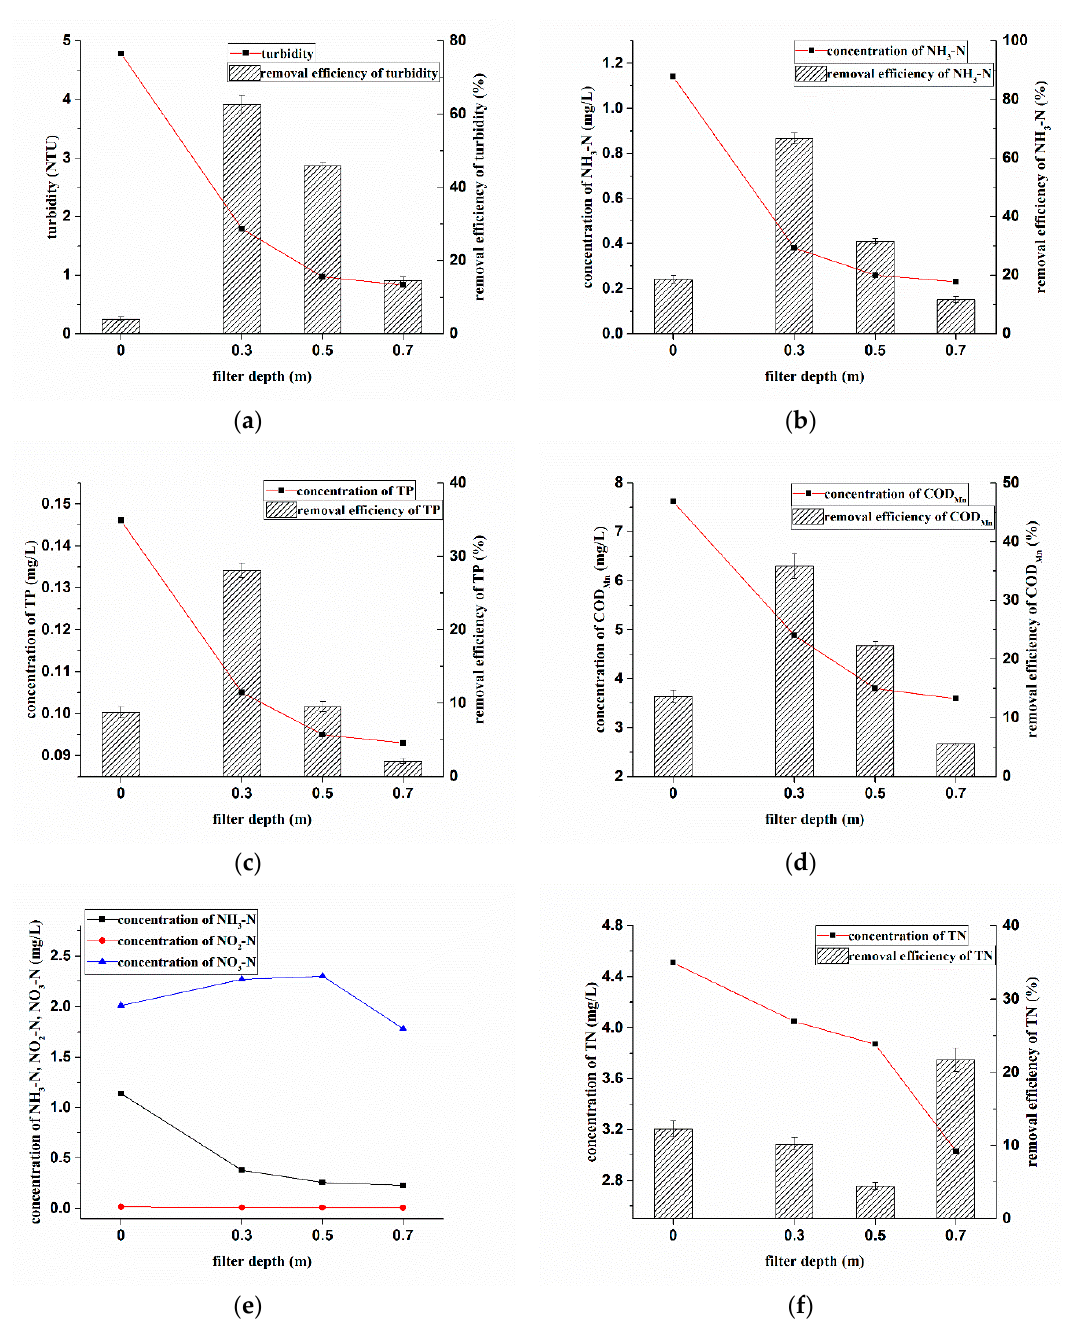
Figure 7. The removal rules of various pollutants (( a ) turbidity, ( b ) NH 3 -N, ( c ) TP, ( d ) COD Mn , ( e ) three forms of nitrogen, ( f ) TN) along different filter layers.